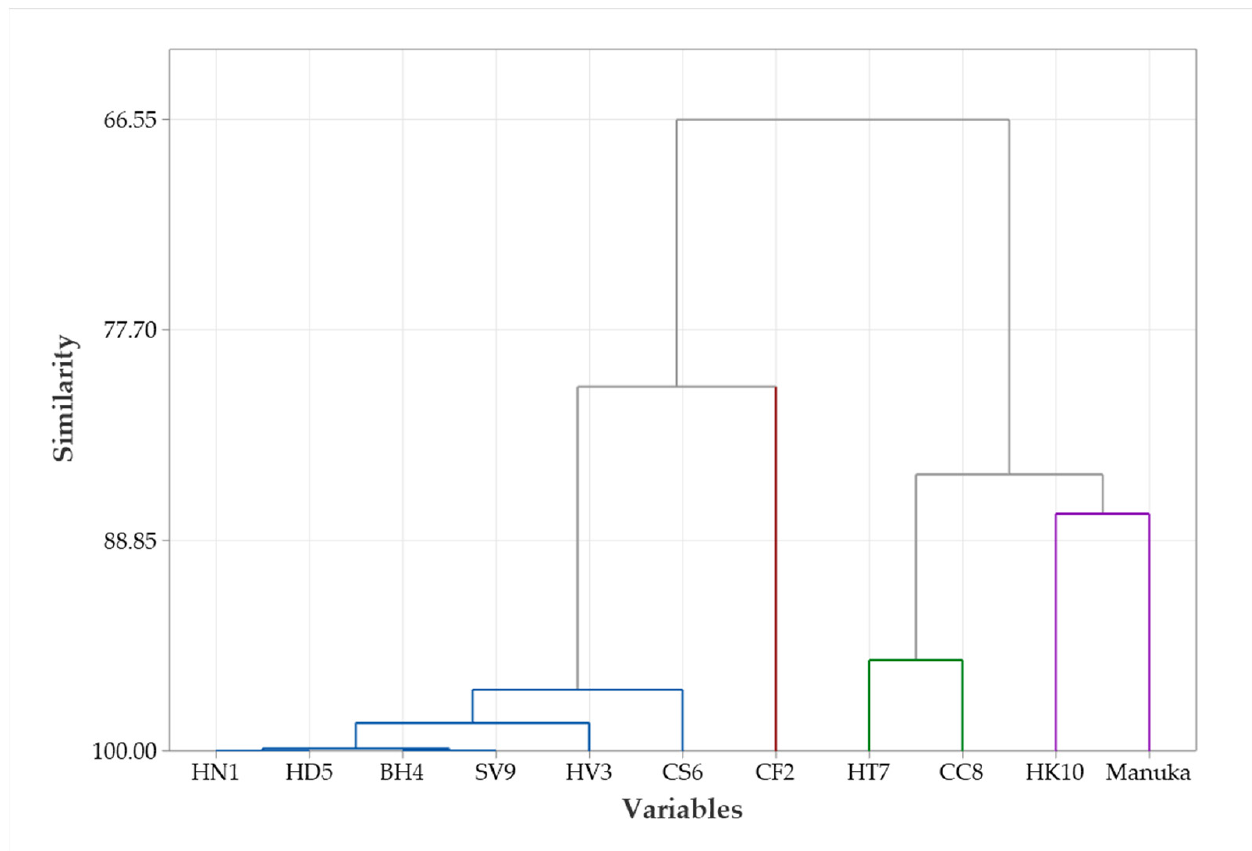
Figure 6. Dendrogram of the cluster analyses for the 30 honey samples.